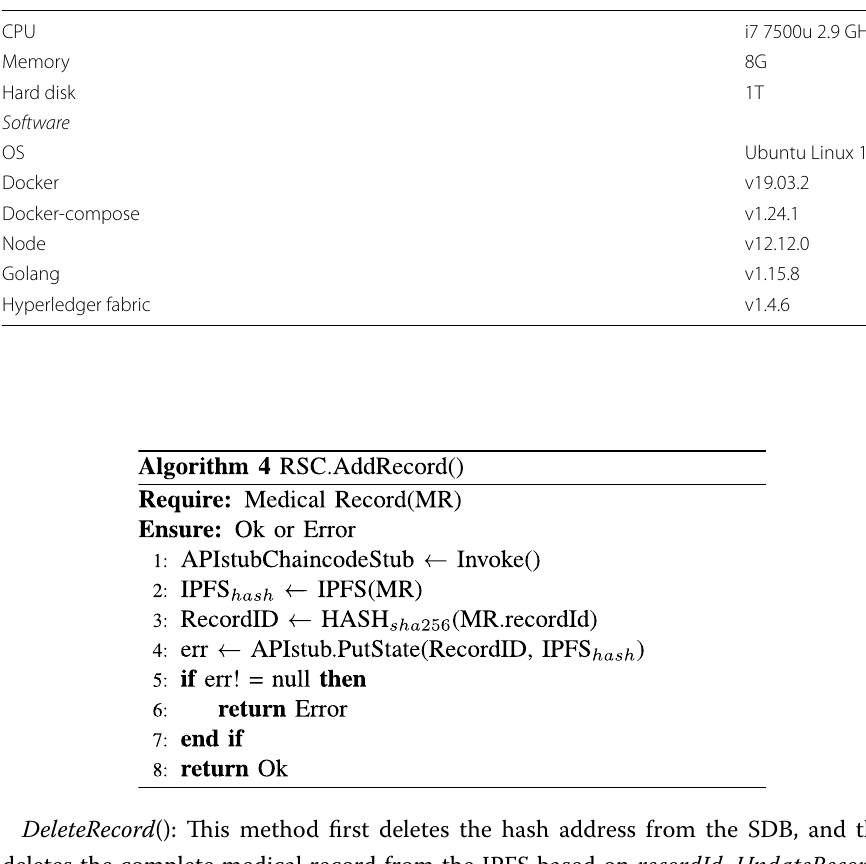
Table 2 Hardware and software resources